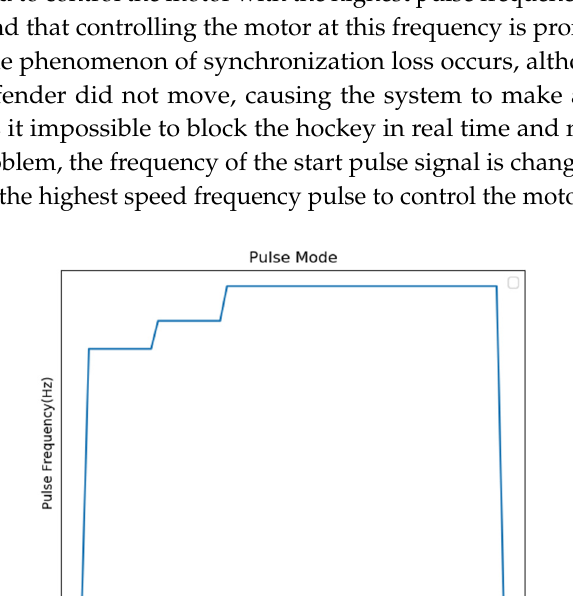
Figure 9. Limit switch installation diagram.